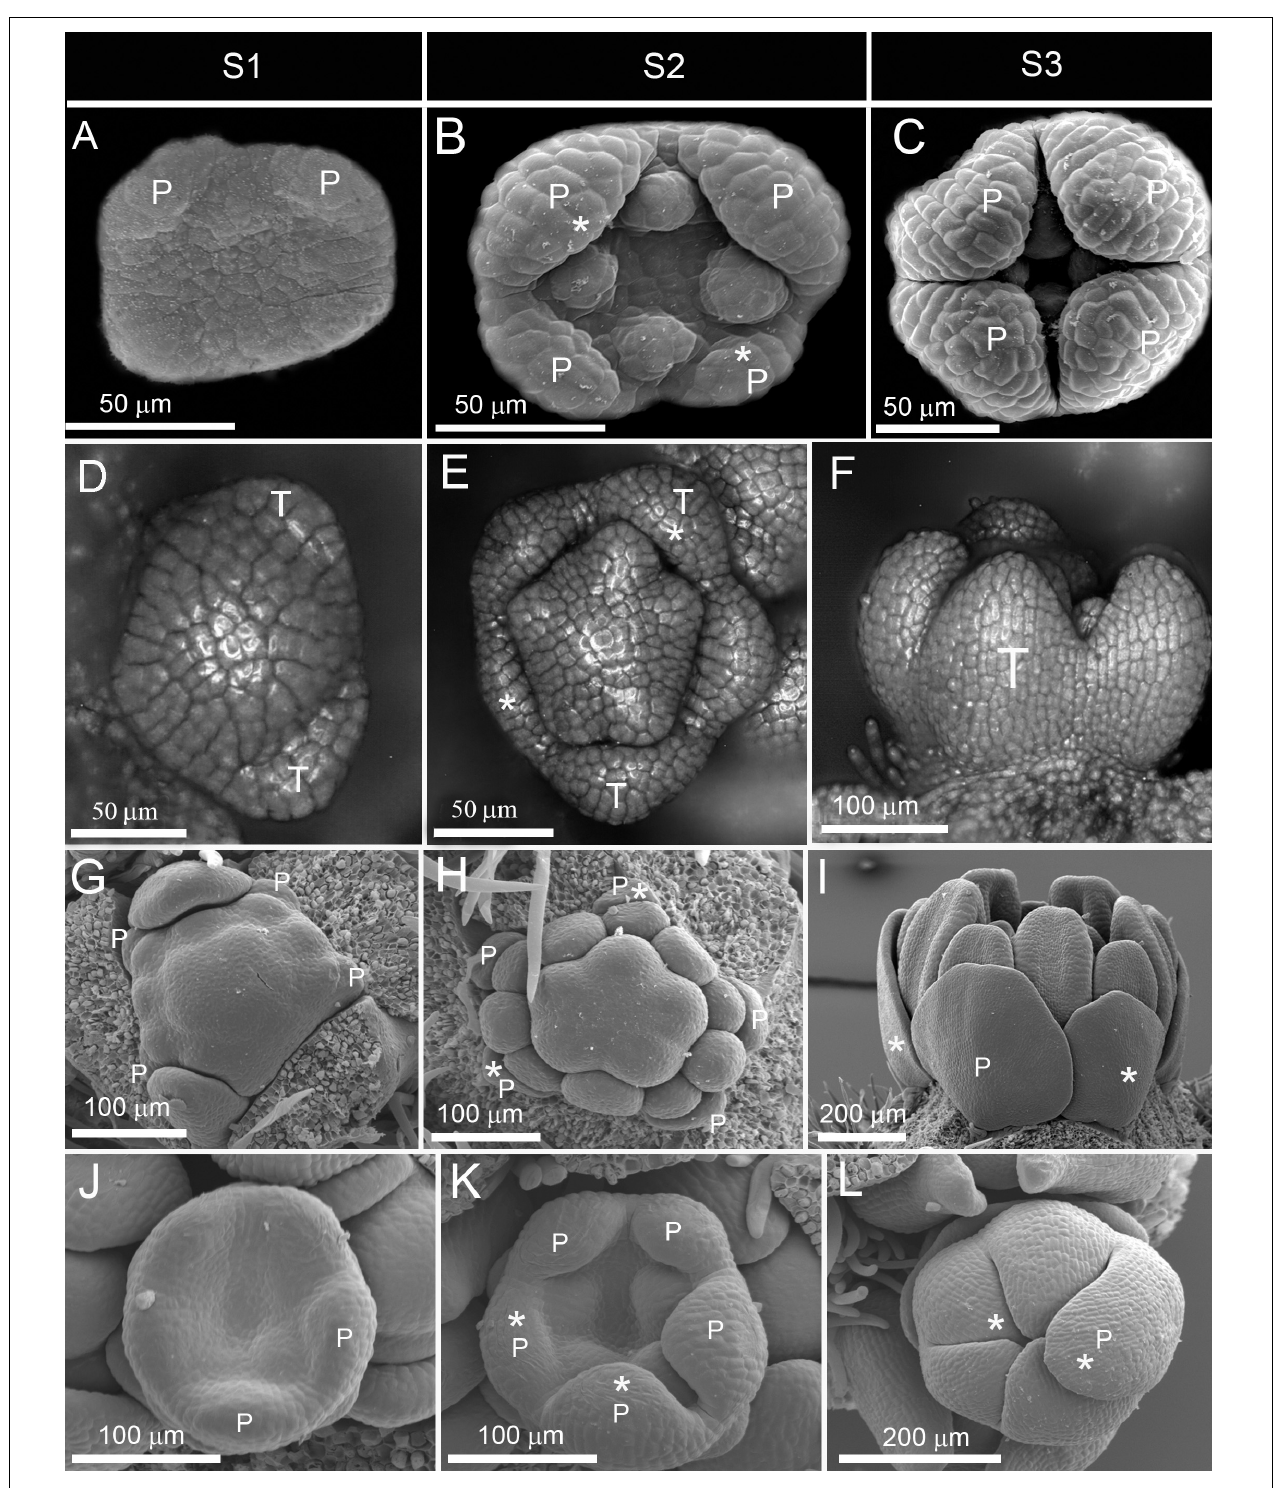
FIGURE 2 | Late establishment of actinomorphy in corolla. (A–F) Non-simultaneous initiation followed by asynchronous enlargement and later synchronization of growth during differentiation in Rubia tinctorium from Rubiaceae (A–C) and Bougainvillea spectabilis from Nyctaginaceae (D–F) . (G–L) Non-simultaneous initiation followed by asynchronous enlargement and differentiation in Larrea divaricata from Zygophyllaceae (G–I) and Patrinia gibbosa from Caprifoliaceae (J–L) . P: petal, S1: initiation phase, S2: enlargement phase, S3: differentiation phase. Note the size difference between the largest and the smallest corolla members during asynchronous enlargement and differentiation (shown by